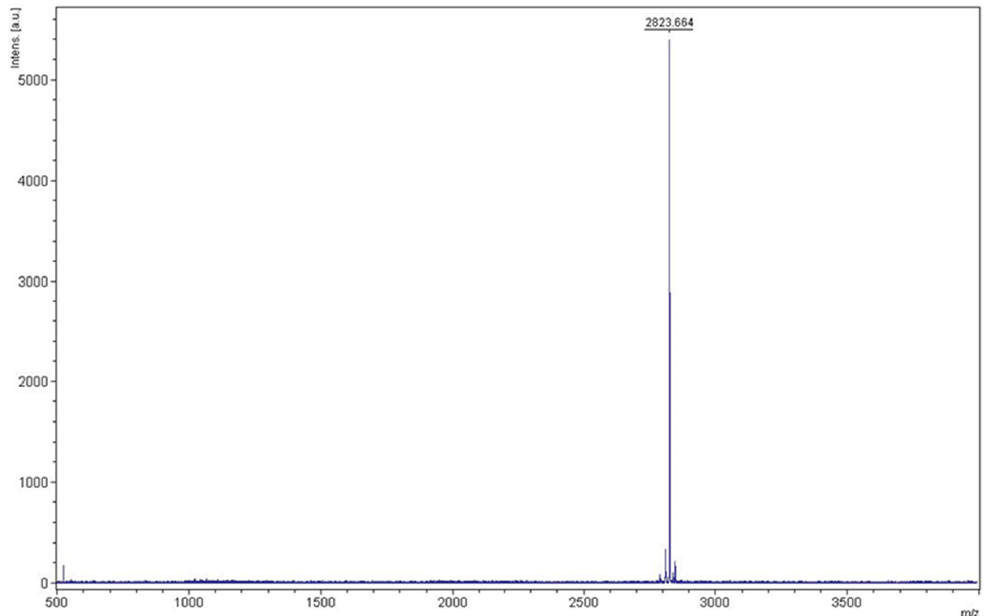
Figure 6. Mass analysis of KR12AGPWR6 from RP-HPLC. The molecular weight of the purified KR12AGPWR6 was found to be 2823.664 Da. The theoretical MW of KR12AGPWR6 was calculated to be 2824.3 Da.